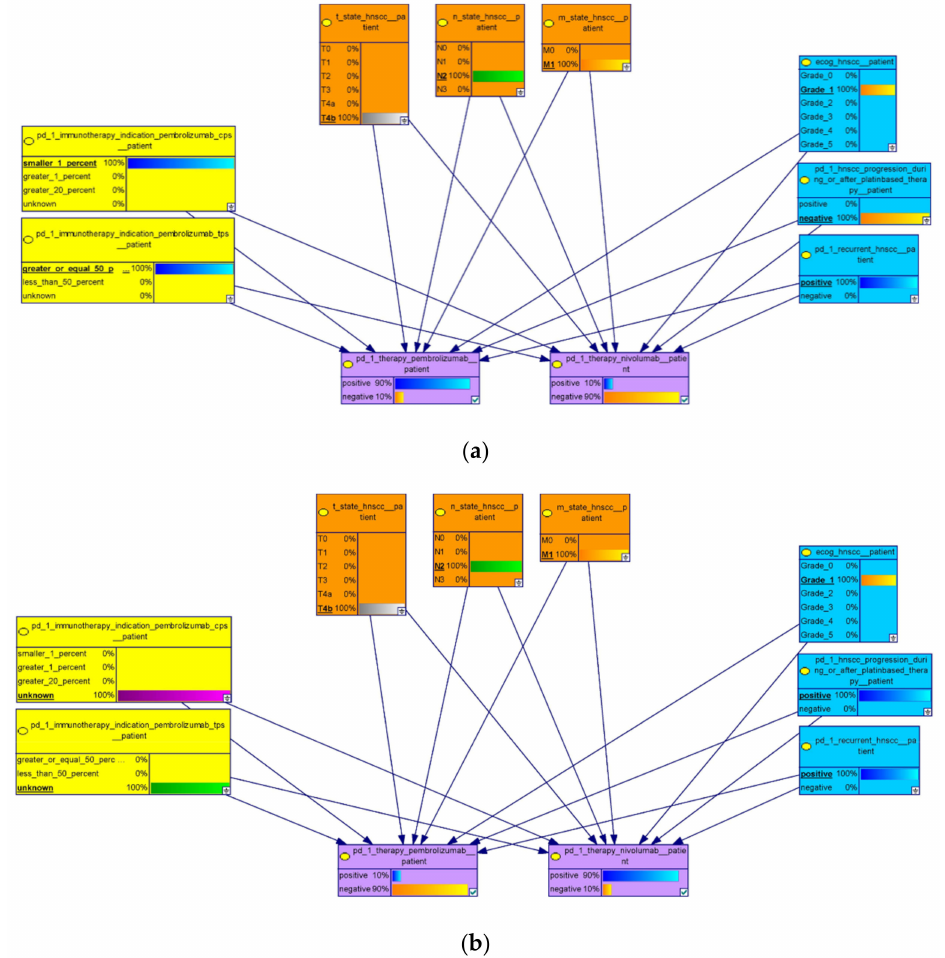
Figure 3. ( a ): A part of the main model, representing the essential variables, leading to a decision regarding whether Pembrolizumab or Nivolumab is a suitable choice or not. The color scheme matches the explanations above. We implemented TNM, the ECOG score and recurrence node from the blue group and PD-1, immunohistochemistry as well as CPS and TPS nodes from the yellow group. ( b ) For R/M HNSCC patients without information about the PD-L1 status and an observed progression during or after platinum-based therapy, the use of Nivolumab is recommended by the model. Because the approval of Nivolumab is independent from TPS and CPS, the probability for Nivolumab treatment increases compared to the use of Pembrolizumab (cf. CheckMate-141 and